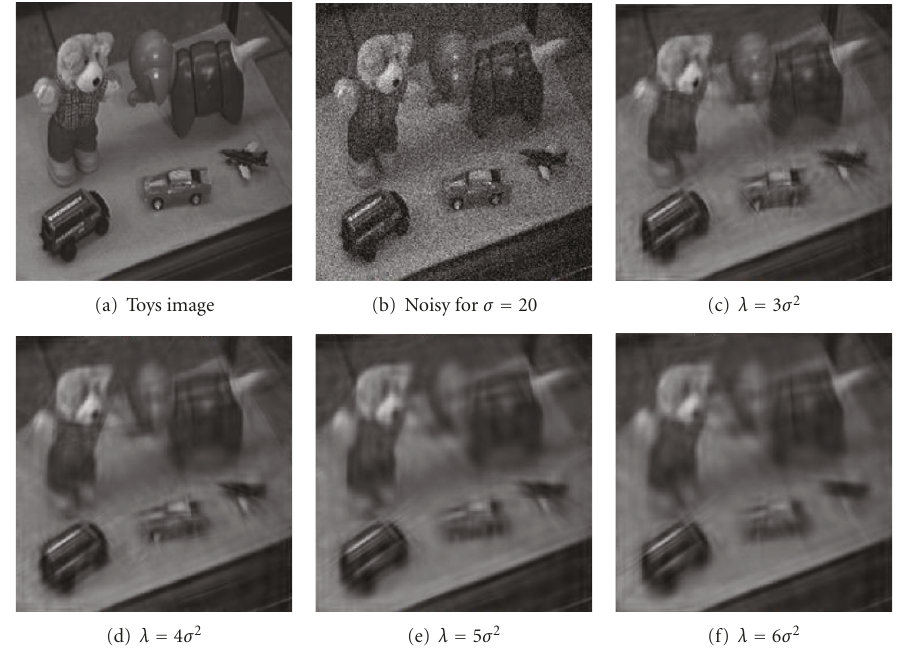
Figure 4: (a) Original “Toys” image. (b) Noisy “Toys” image for Gaussian noise with standard deviation σ = 20. (c)–(f) Denoising of “Toys” image shown in (b) where the curvelet transform is hard-thresholding according to (17) for di ff erent choices of λ